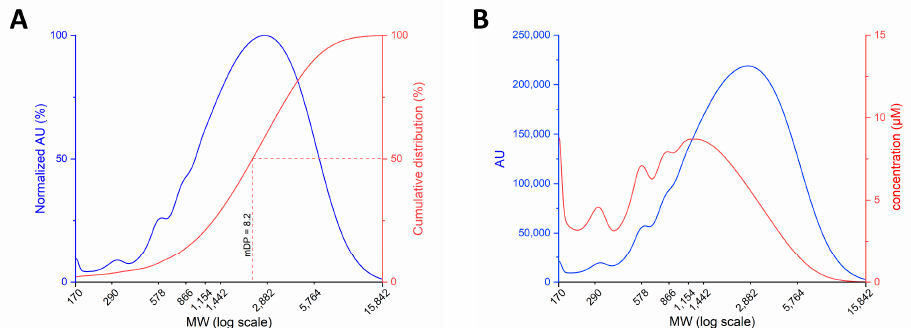
Figure 3. GPC profiles of Ecovitis™ procyanidins as function of their MW: ( A ) blue line: normalized AU (%); red line: cumulative distribution and median degree of polymerization (mDP), expressed as the number of catechin units contained at the average molecular weight; ( B ) blue line: catechin absorbance (AU); red line: concentration ( µ molar) of PACs along with the GPC profile. The latter was obtained by dividing the molar concentration of catechin equivalents calculated from absorbance for the DP corresponding to the MW in the plot.